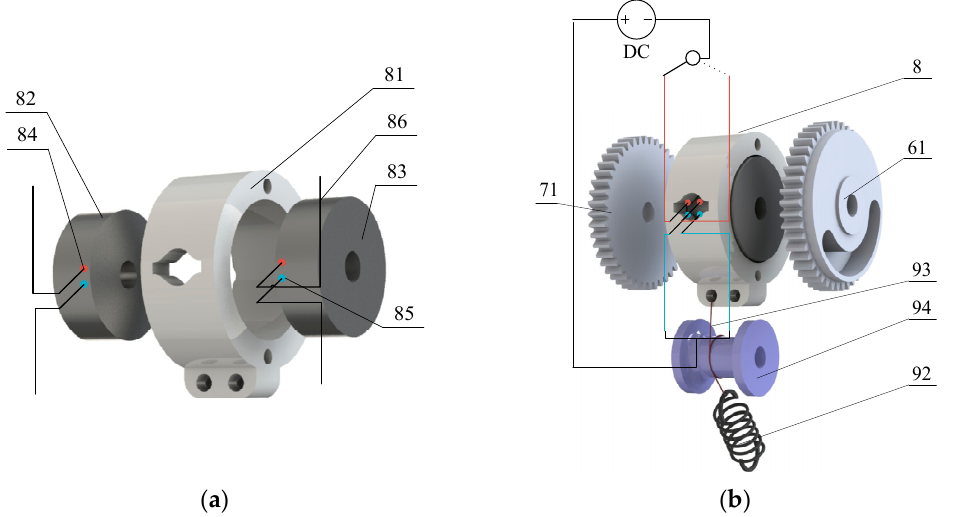
Figure 6. Mechanical structure of the electromagnetic switching device: ( a ) structure of the electro- magnetic switching device; ( b ) function diagram. Components: 61—first gear; 71—fourth gear; 8— electromagnetic switching device; 81—switching sleeve shell; 82—electromagnet 1; 83—electromagnet 2; 84—anode; 85—cathode; 86—conductor; 92—tension spring; 93—string; 94—reeling sleeve.